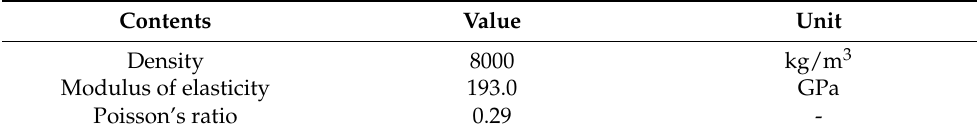
Figure 8. The shape of unit cell. ( a ) Circular pore. ( b ) Elliptical pore. Table 2. Mechanical properties of SUS304